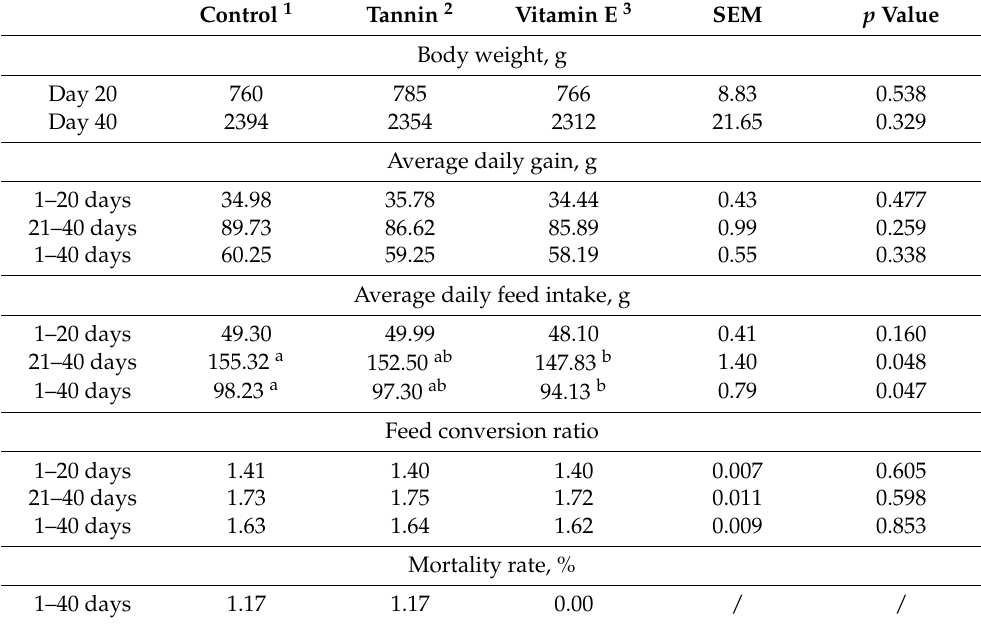
Table 2. Effect of chestnut tannins and vitamin E on the growth performances of broiler chickens. Control 1 Tannin 2 Vitamin E 3